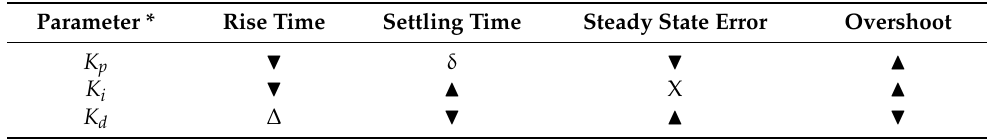
Table 5. Effect of PID gains on response parameters of the system [42].